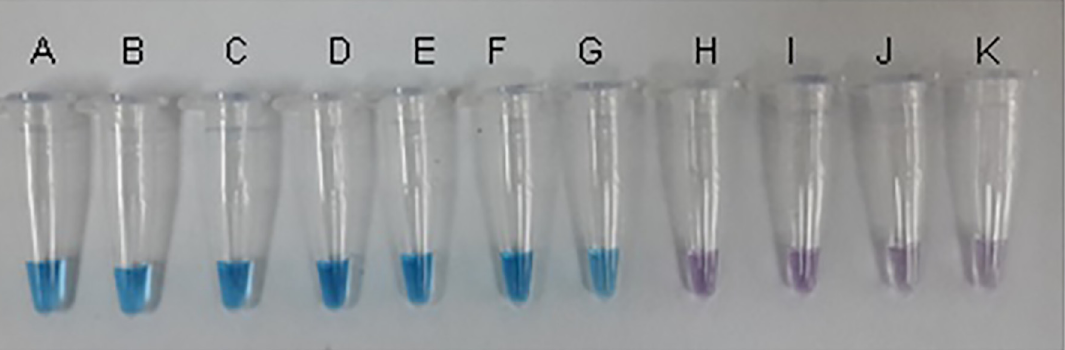
Fig 1. Visualization of LAMP assay products following addition of HNB dye. The color changes from violet (negative reaction) to sky blue (positive reaction). Tube A and B: DENV 1 serotypes; tube C and D: DENV 2 serotypes; tube E and F: DENV 3 serotypes; tube G: DENV 4 serotype; tube H: JEV; tube I: CHIKV; tube J: SINV; tube K: Negative control (distilled water).